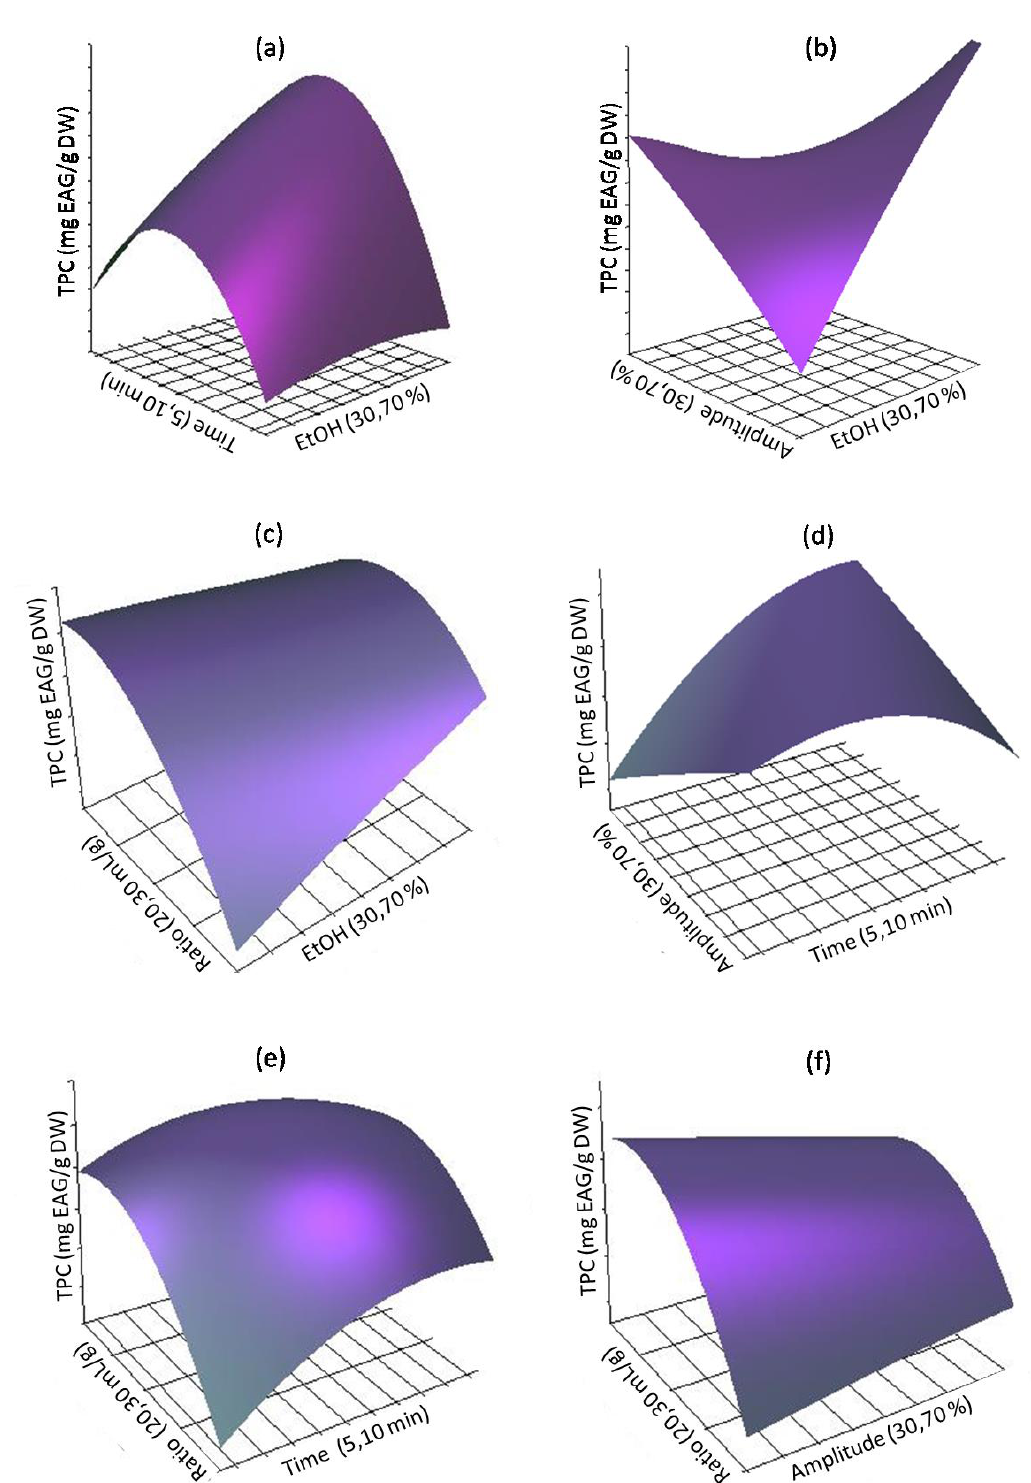
Figure 1. Response surface analysis for the Total phenolic compounds (TPC) with UAE with respect to: ( a ) ethanol concentration and irradiation time; ( b ) ethanol concentration and amplitude; ( c ) ethanol concentration and solvent-to-solid ratio; ( d ) extraction time and amplitude; ( e ) extraction time and solvent-to-solid ratio; and ( f ) amplitude and solvent-to-solid ratio.